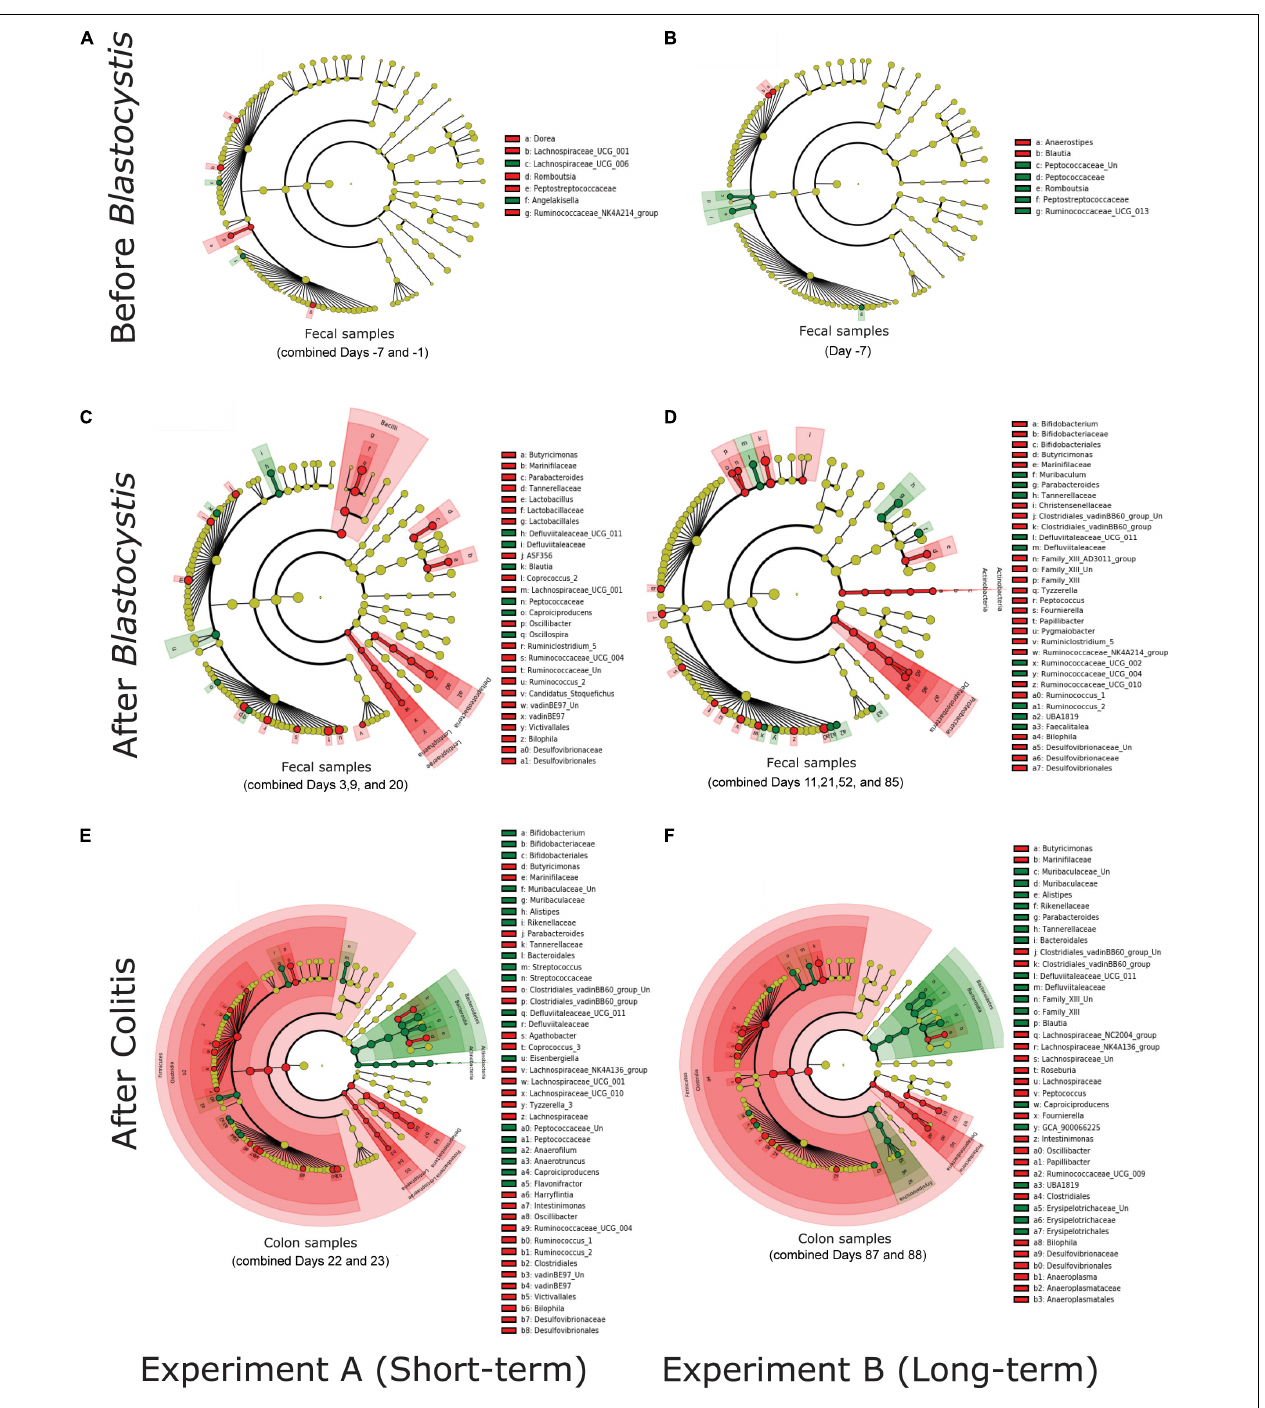
FIGURE 8 | Blastocystis ST3 colonization alters the abundance of a varied suite of bacterial taxa before and after colitis, some of which are consistent across the short-term (3 weeks) and the long-term (13 weeks) colonization. Differential relative abundance of taxa was assessed with linear discrimination analysis of effect size (LEfSe) analysisat the phylum to the genus level. Each cladogram represents all taxa in the study. Yellow circles indicate no difference in relative abundance. Bacterial taxa significantly enriched in Blastocystis ST3-colonized group are in red (Kruskal-Wallis P < 0.05), while bacterial taxa enriched in the control are in green. (A,B) LEfSecladograms from rat fecal samples before Blastocystis colonization. (A) Short-term colonization with combined Days − 7 and − 1. (B) Long-term colonization with Day − 7. (C,D) LEfSecladograms from rat fecal samples after Blastocystis ST3 colonization. (C) Short-term colonization withcombined Days 3,9, and 20. (D) Long-term colonization with combined Days 11, 21, 52, and 85. (E,F) LEfSecladograms from colon samples after colitis induction. (E) Short-term colonization with combined Days 22 and 23. (F) Long-term colonization with combined Days 87 and 88. All LEfSecladograms from singleand combined days, and all sample’s types and from both experiments and Pilot studies are presented in Supplementary Figures 1–4